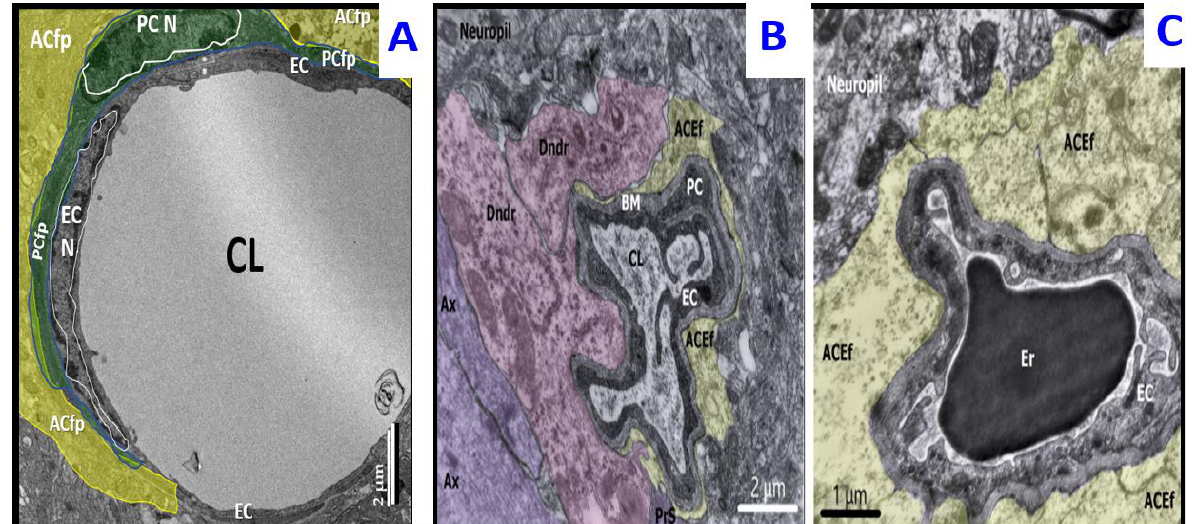
Figure 1. Ultrastructure of the cortex in sepsis-associated encephalopathy. Panel ( A ) demonstrates the full expansion of the capillary lumen (CL) as observed in control models. Note that astrocyte foot processes (ACfp) have been pseudo-colored yellow and that pericyte (PC) and pericyte foot processes (PCfp) has been pseudo-colored green. Panel ( B ) depicts deformation and partial collapse of the capillary lumen with condensation of the blood plasma. Neuronal dendrites (pink) are attached to the structures of the BBB in the cortex of a survived rat in compensated sepsis (CLP-A group 48 h after CLP procedure). Panel ( C ) depicts the partial collapse of the capillary lumen with deformed erythrocyte. Pronounced edema and absence of multivesicular bodies (MVBs) in astroglial endfeet (pseudo-colored yellow) in the cortex of a non-surviving rat in decompensated sepsis (CLP-B group 48 h after CLP procedure). ACEf = astrocyte endfeet; ACfp = astroglial capillary endfeet; Ax = axon; BM = basement membrane; Dndr = dendrite; EC = endothelial cell; Er = erythrocyte N = nucleus; PC = pericyte, Pcfp = pericyte foot process; PrS = presynaptic terminal.